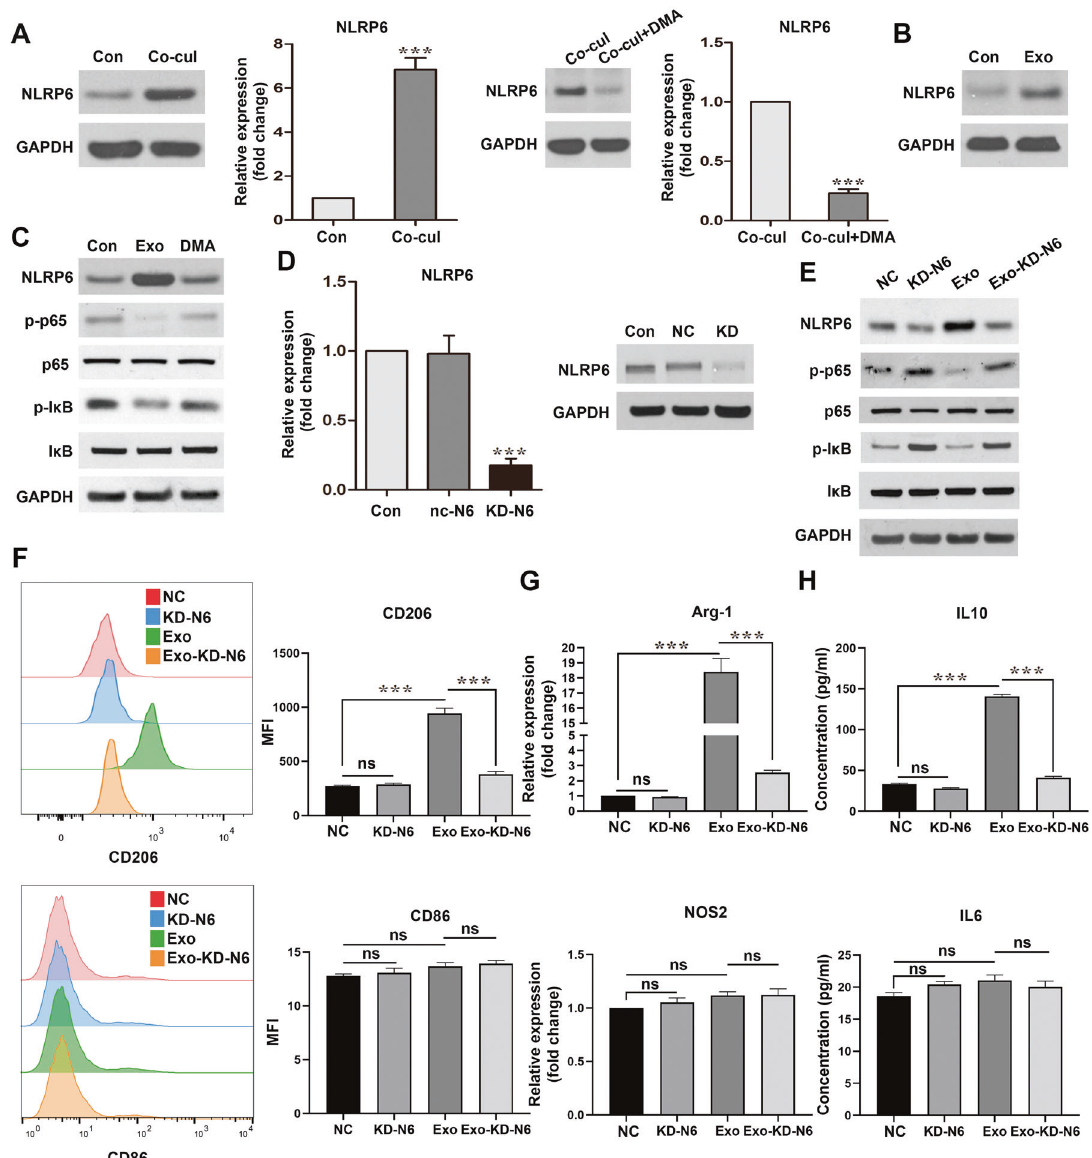
Fig. 5 NLRP6 is required for macrophage phenotype switch. A Immunoblot and qRT-PCR analyses of NLRP6 expression in BMDMs co- cultured with RT SCLC cells with or without DMA treatment ( n = 3). B Immunoblot analyses of NLRP6 expression in BMDMs co-cultured with SCLC-derived exosomes ( n = 3). C Immunoblot analysis of I κ B α , p-I κ B α , p65, and p-p65 expression in BMDMs, after culturing with exosomes with or without DMA treatment of the SCLC cells ( n = 3). D qRT-PCR and immunoblot analyses to con fi rm the knockdown ef fi ciency in NLRP6- silenced BMDMs. E Immunoblot analysis of NLRP6, I κ B α , p-I κ B α , p65, and p-p65 expression ( n = 3). F Flow cytometry of the expression levels of the M2 polarization marker CD206 and M1 polarization marker CD86 in BMDMs after culturing with exosomes in BMDMs with or without NLRP6 silencing ( n = 3). G qRT-PCR analyses of the expression levels of the M2 polarization marker Arg-1 and M1 polarization marker NOS2 in BMDMs ( n = 3). H ELISA results of IL10 and IL6 in the supernatant of BMDMs ( n = 3). Con, untreated BMDMs. NC, BMDMs transfected with negative control siRNA. KD-N6, BMDMs transfected with NLRP6 siRNA. Exo, BMDMs co-cultured with SCLC-derived exosomes. Exo-KD-N6, BMDMs with NLRP6 silencing and co-cultured with SCLC-derived exosomes. Bar graphs show the mean ± SEM; *** P < 0.001. BMDMs bone marrow-derived macrophages, SCLC small cell lung cancer, DMA dimethyl amiloride, SEM standard error of